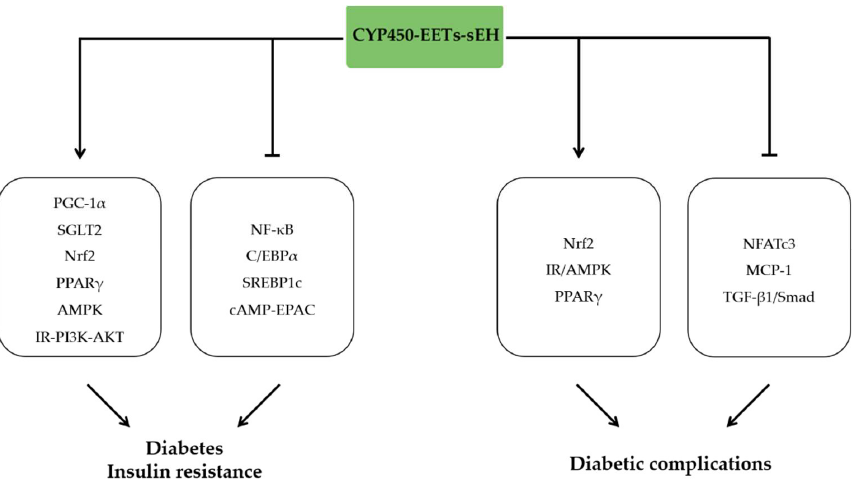
Figure 4. The anti-inflammatory effects of EETs in metabolic disorder. EETs ameliorate diabetes and insulin resistance by activating PGC-1 α , PPAR γ , AMPK, and IR-PI3K-AKT signaling pathways and inhibiting NF- κ B, C/EBP α , and SREBP1c expression. EETs attenuate diabetic complications by increasing Nrf2, IR/AMPK, and PPAR γ signaling pathways and inhibiting NFATc3 and TGF- β 1/Smad